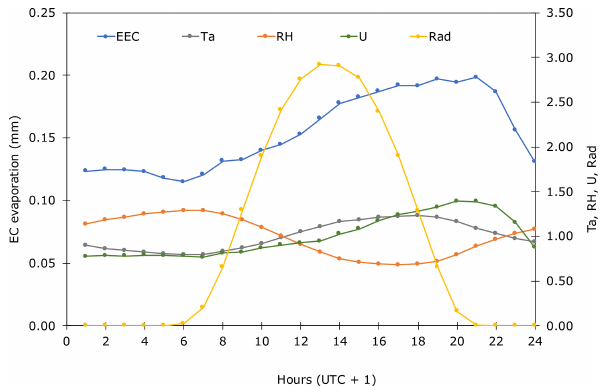
Figure 5. Mean daily cycle of the EC evaporation ( E EC ) (left y axis) and normalised air temperature ( T a ), relative humidity (RH) of air, wind speed ( U ), and solar radiation (Rad) (right y axis) from June to September 2014 at Alqueva-Montante